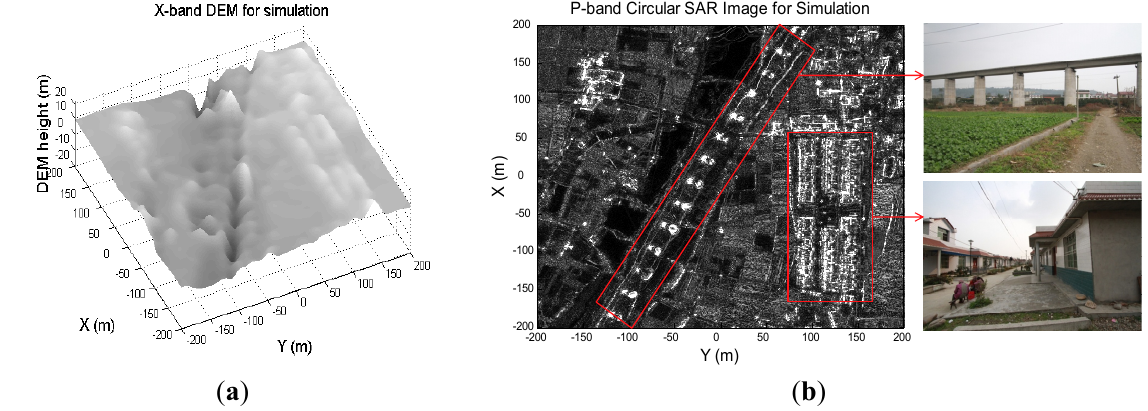
Figure 15. 3-D distributed simulation input: ( a ) Airborne X-band DEM. ( b ) Airborne P-band Circular SAR image.